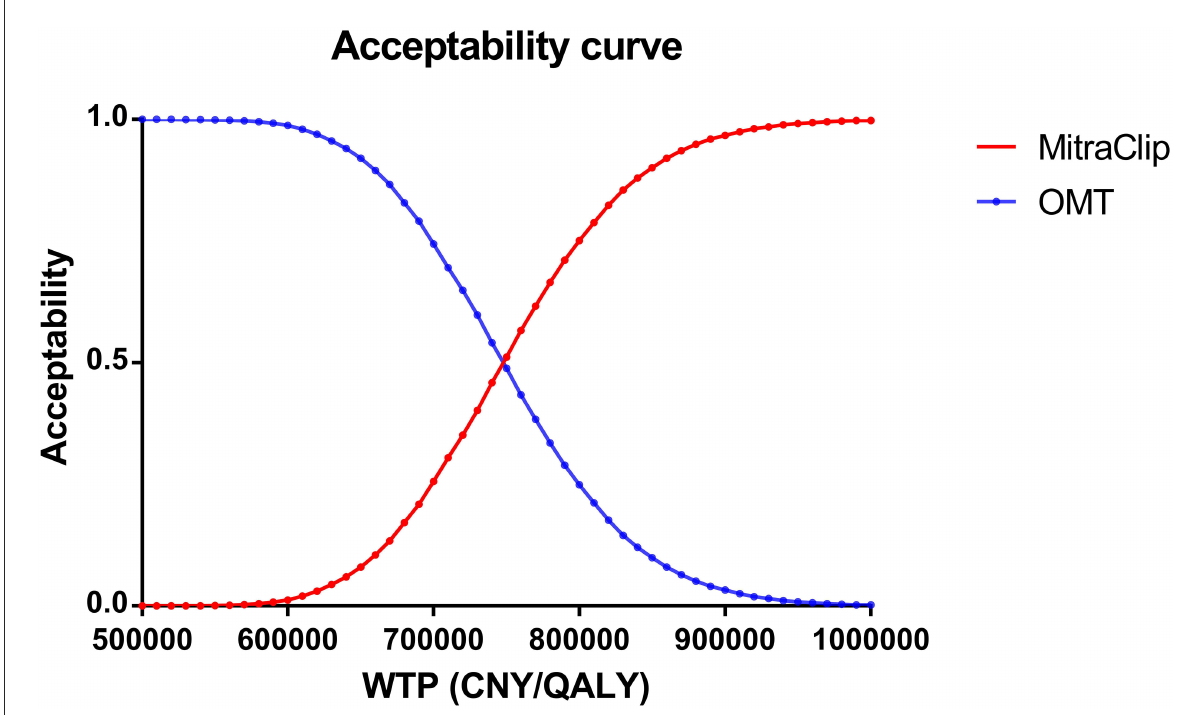
FIGURE4 Cost-effectiveness acceptability curve based on probabilistic sensitivity analysis. The acceptability of MitraClip grew higher as the WTP threshold increased. When the WTP threshold was about 750,000 CNY/QALY, MitraClip shared similar acceptability with